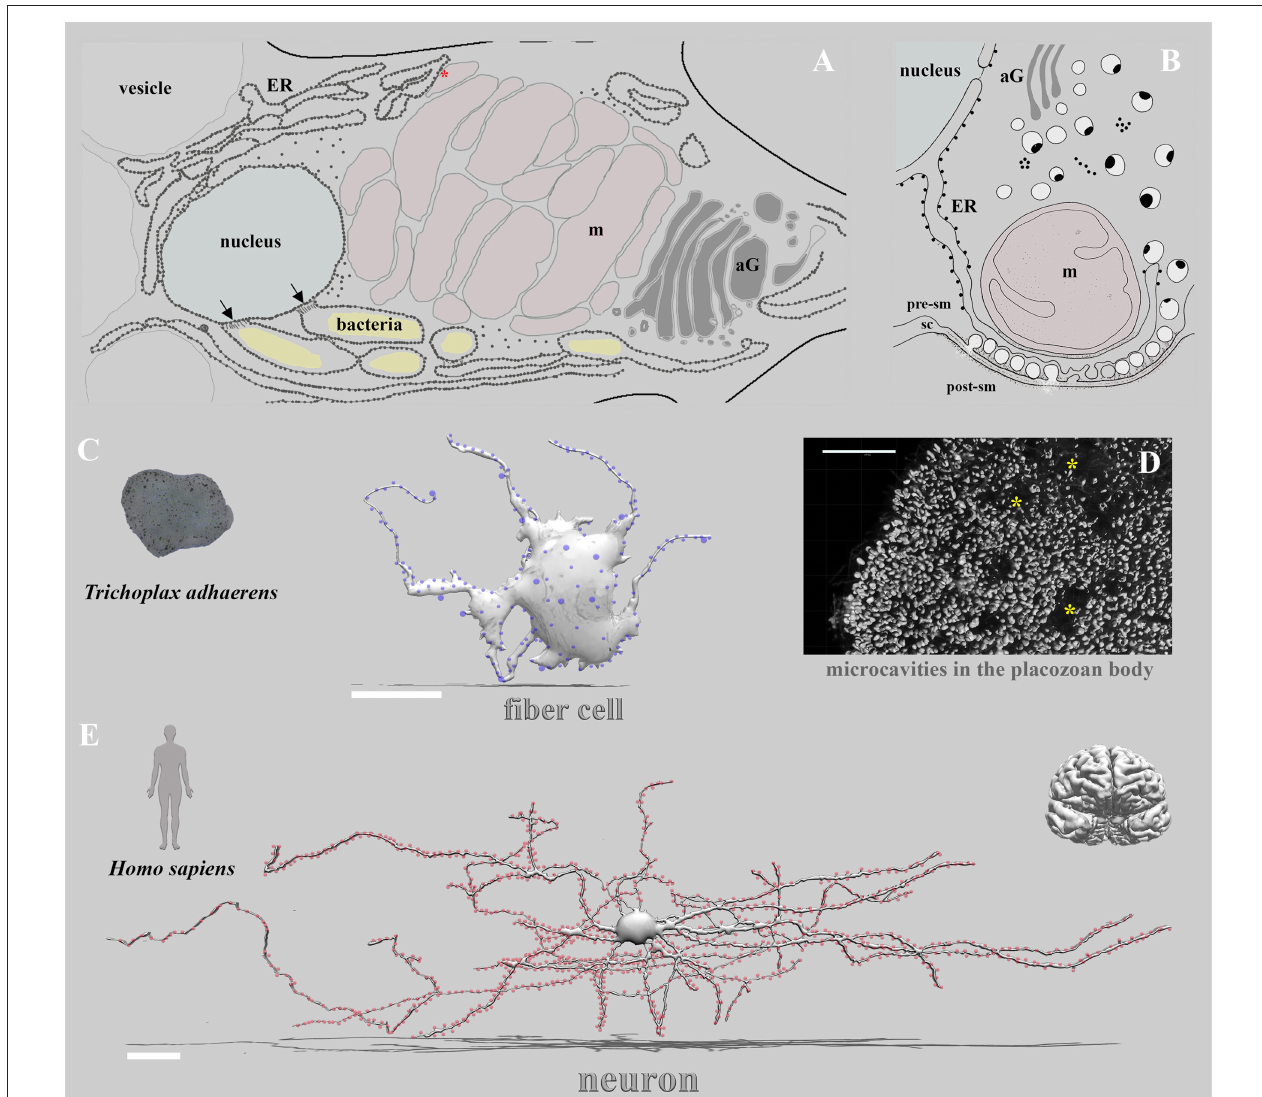
FIGURE 1 | Non-synaptic vs. synaptic transmission: extreme cases of alternative integrative systems. Three remarkable examples of cells involved in the behavioral integrations are illustrated: the placozoan fiber cell (A,C) , unique ctenophore tripartite chemical synapse ( B , modified from Hernandez-Nicaise, 1991, see text), and the pyramidal human neuron (E) . (A) Details of ultrastructural organization of the fiber cell in Hoilungia hongkongensis (modified from Romanova et al., 2021, Figure 5). Inside fiber cells, an extended endoplasmic reticulum entwined all cell compartments, especially mitochondria complex (formed presumed mitochondrial contact site—red asterisk), nucleus, and bacteria. Black arrows indicate specialized contact sites (Dumoux and Hayward, 2016) to the nucleus with encapsulated bacteria within ER-type structures with ribosomes (dotted areas). (C) The left image shows the organization disk-shaped nerveless placozoan, Trichoplax , which contains no recognized neurons, muscles, or sensory organs but displays coordinated behaviors and action potentials (Smith et al., 2015, 2019; Senatore et al., 2017; Armon et al., 2018; Varoqueaux et al., 2018; Fortunato and Aktipis, 2019; Romanova et al., 2020b). The middle image shows the schematic reconstruction of a placozoan fiber cell with prominent sites (blue dots) of putative secretory/paracrine (non-synaptic) regions (modified from scanning and transmission electrom microscopy datasets (Romanova et al., 2021). The right image (D) shows the microcavities (asterisks) (Romanova, 2019) as suggested regions of non-synaptic communications and integration in placozoans (Moroz et al., 2021b). (E) The reconstruction of a pyramidal neuron (modified from https://ai.googleblog.com/2021/06/a-browsable- petascale-reconstruction-of.html and Riessland et al., 2017; Shapson-Coe et al., 2021). Red dots are exemplar synapses on the pyramidal neuron. Blue dots are recognized vesicles and exosomes around the fiber cell (C) . Scale bars: Fiber cell—20 µ m; Neuron—50 µ